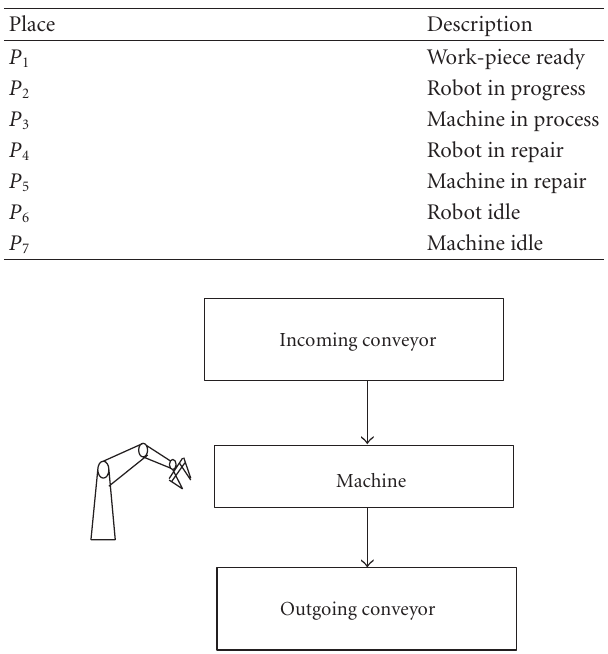
Table 9: Description of Places of Figure 7.